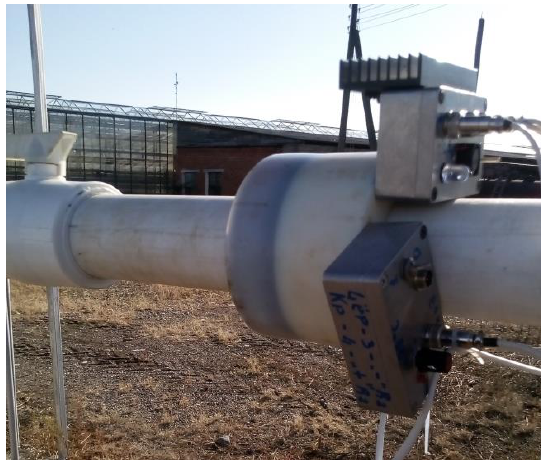
Figure 12. Acoustic–magnetic device installed on a pipe of heating